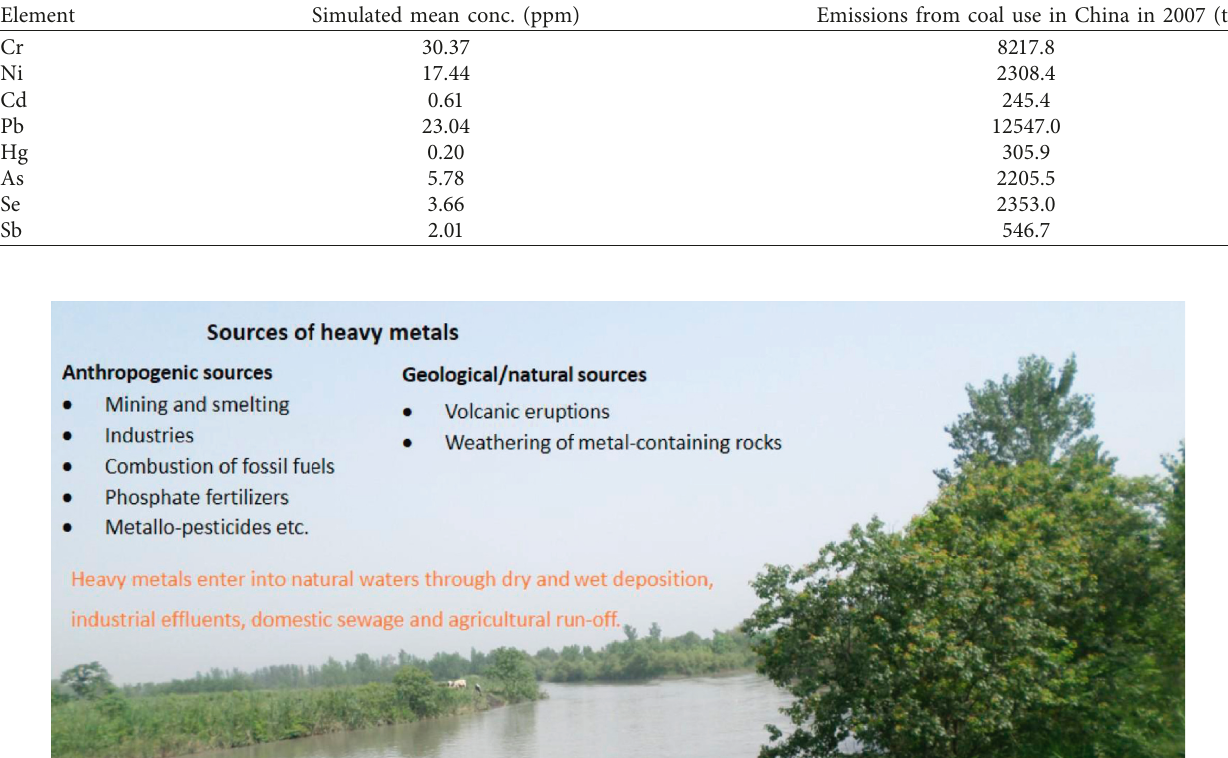
Table 1: Some environmentally important data for key hazardous trace elements (HTEs), of prime environmental concern, in Chinese coals